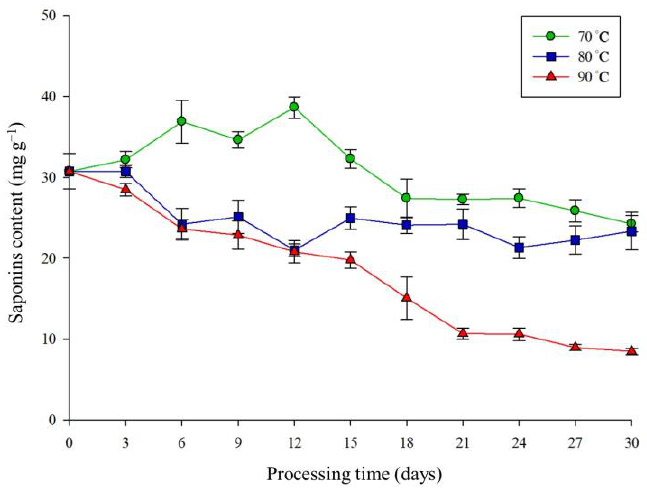
Figure 1. Changes in the saponin content of radish during thermal processing. Thermally processed radish (TPR) was treated at 70 °C, 80 °C, or 90 °C from 0 to 30 days. The error bars represent the standard deviation ( n = 3).